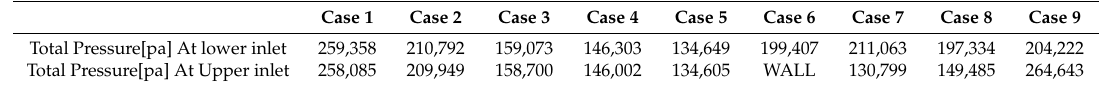
Table 3. Boundary